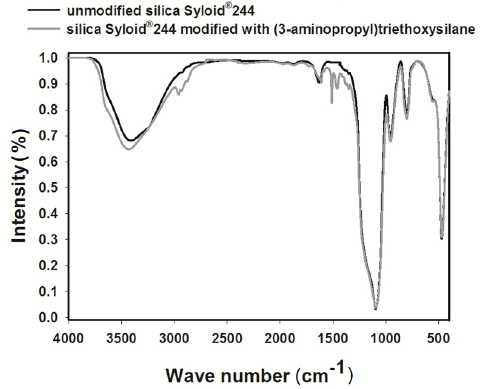
Figure 1: FT-IR spectra of unmodified and modified